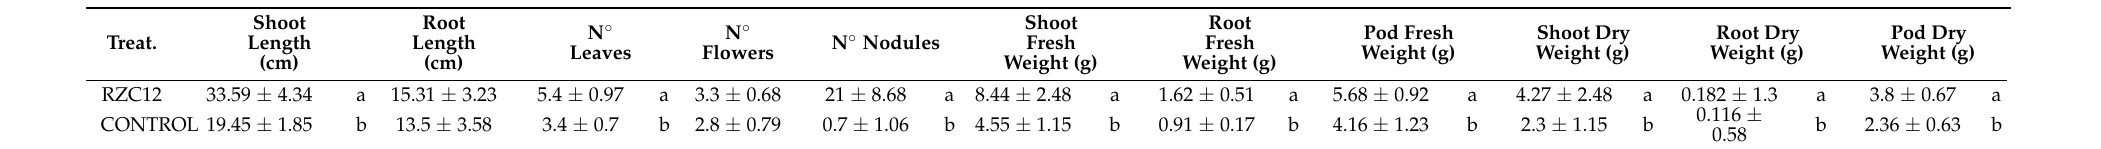
Table 6. Effect of inoculation with Rhizobium-RZC12 on the growth and root nodulation of red kidney beans in field